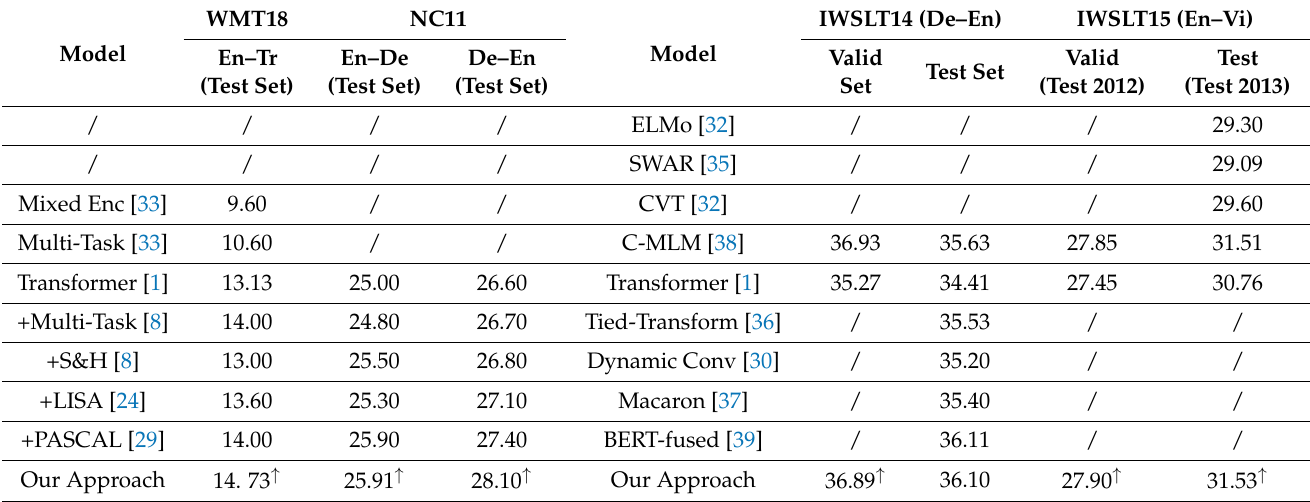
Table 2. Performance of different machine translation approaches on various datasets.